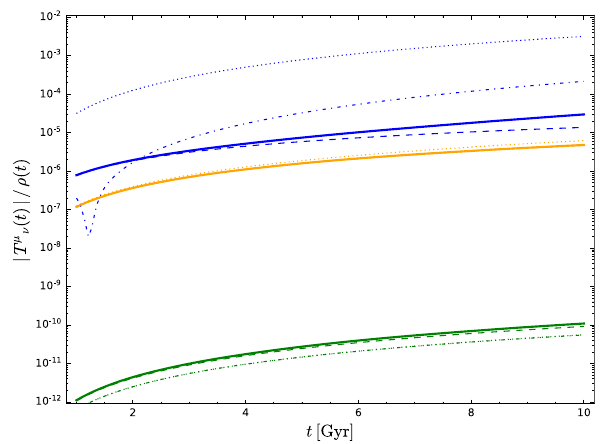
Fig. 5 The elements of the energy–momentum tensor relative to the energy density, evaluated at the center of the overdensity region. The blue curves represent pressure-like terms T i j | i = j , the orange ones cor- respondtotheelements T 0 i ,whilethegreencurvesreferto T i j | i (cid:4)= j .The second-order quantities are plotted by the dotted lines, the third-order by the dashed-dotted lines, while the fourth-order by the dashed lines. Solid lines correspond to the exact energy–momentum tensor described in Sect.